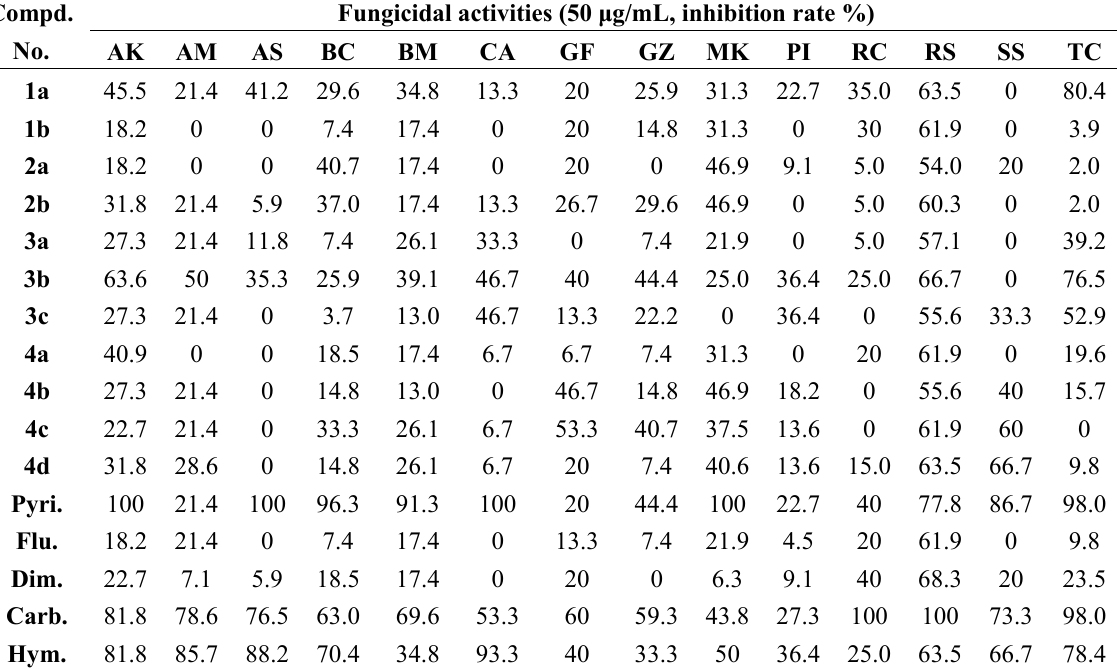
Table 1. The fungicidal activities of three series of pyrimidine derivatives. Compd.